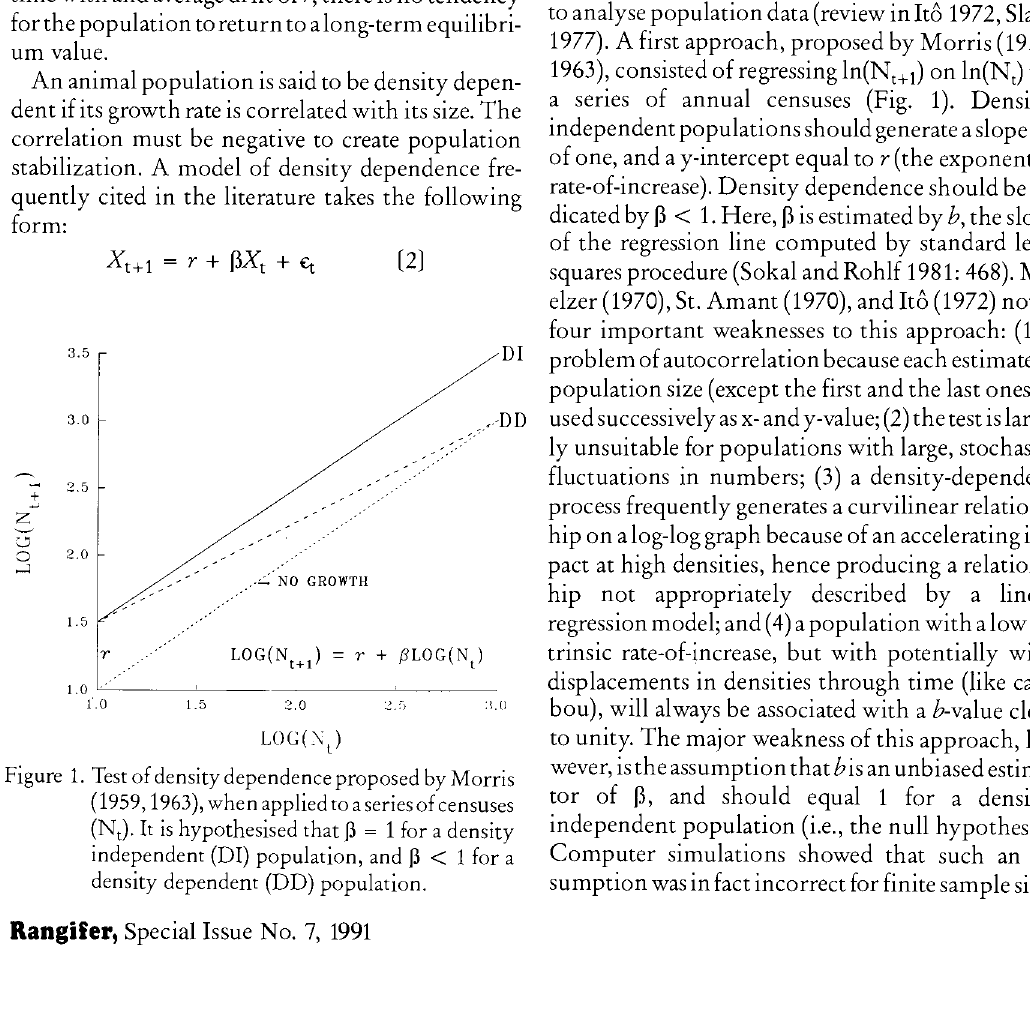
Figure 1. Test of density dependence proposed by Morris (1959,1963), when applied to a series of censuses (N t ). It is hypothesised that ß = 1 for a density independent (DI) population, and ß < 1 for a density dependent (DD)